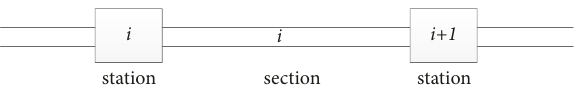
Figure 4: The relationship between section indexes and station